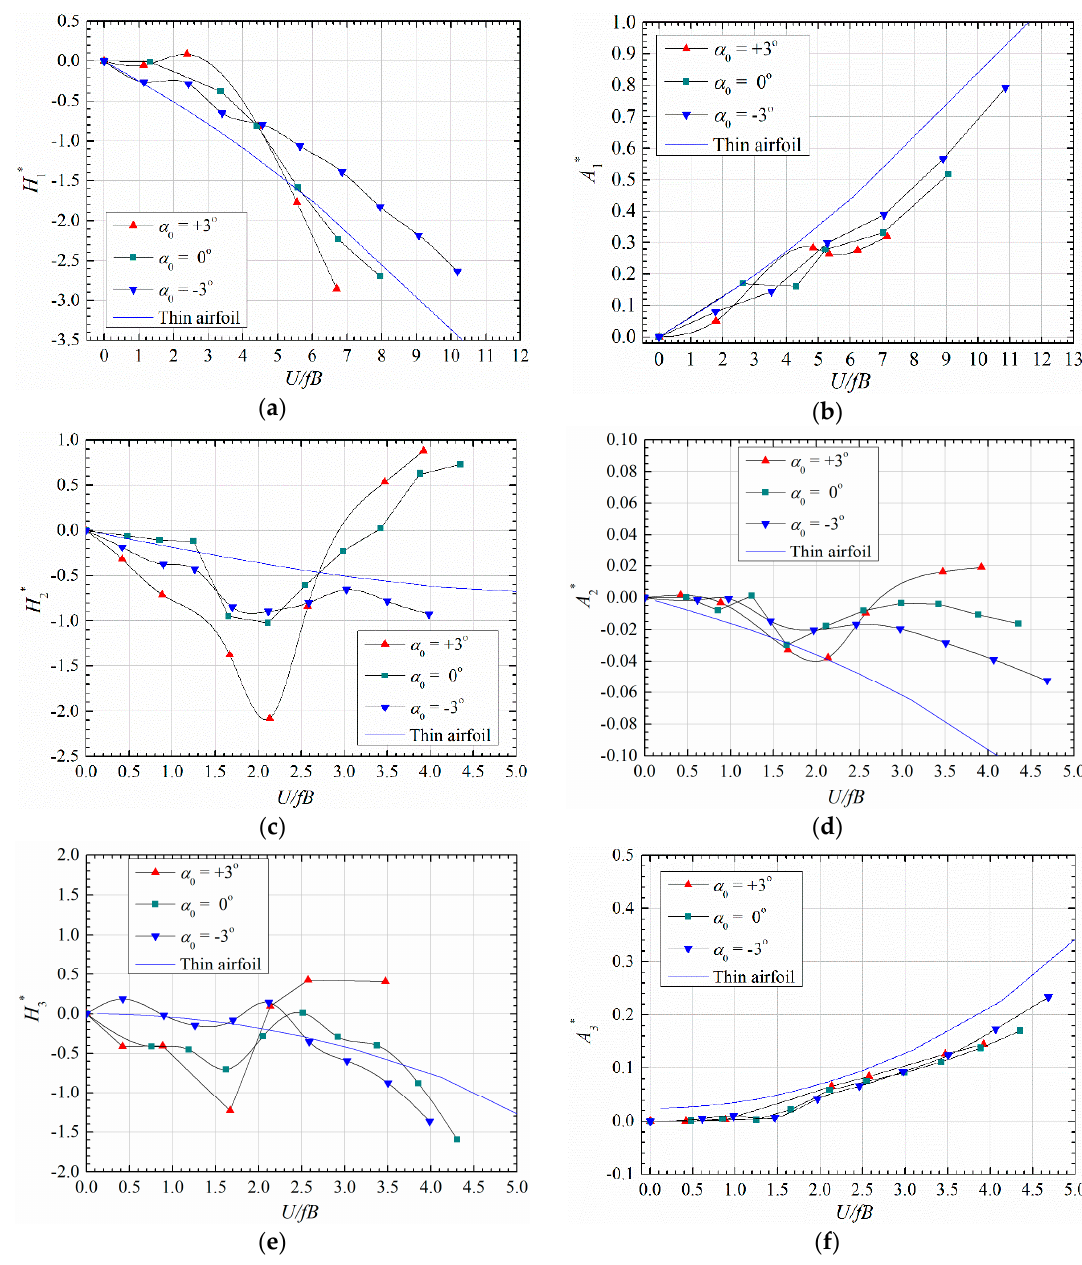
Figure 5. Identified linear flutter derivatives for different attack angles (Case A1, B1 and C1). ( a ) H ∗ ; ( b ) A ∗ ; ( c ) H ∗ ; ( d ) A ∗ ; ( e ) H ∗ ; ( f ) A ∗ . 1 2 2 2 3 3